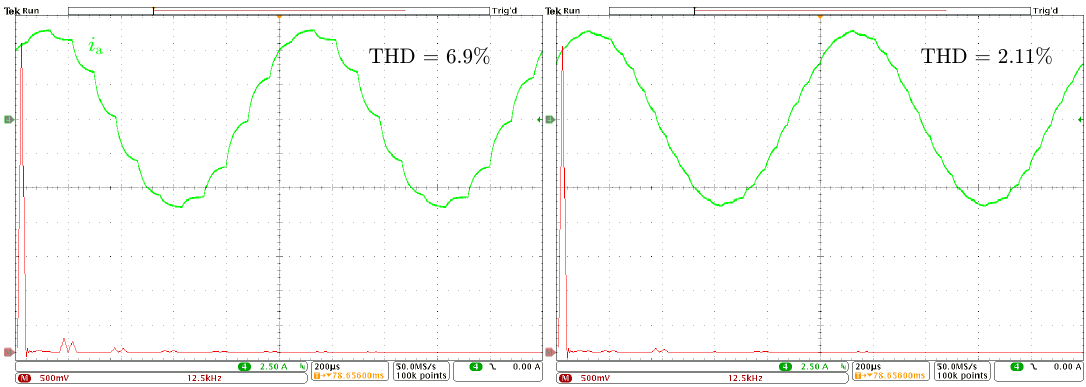
Figure 17. Load currents and their spectra for the modular VSI with two-level ( left ) and three-level ( right )